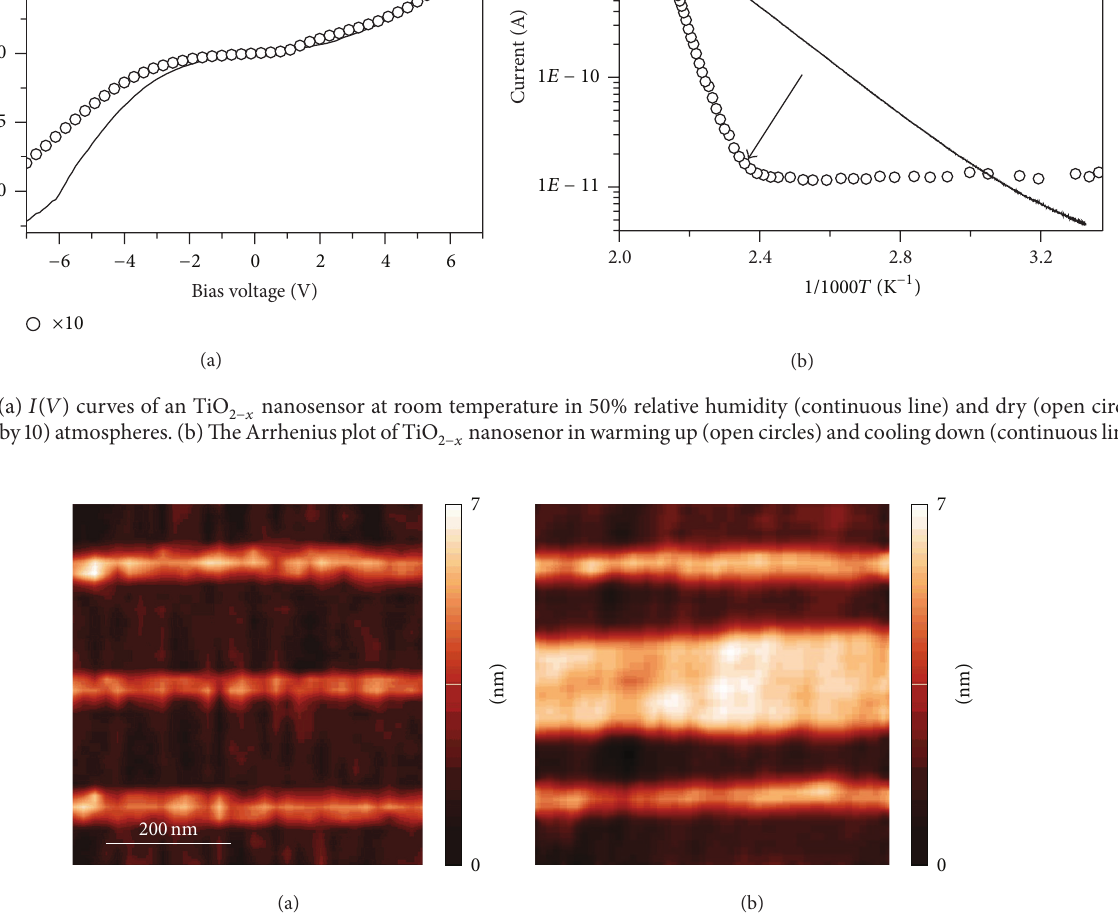
Figure 9: (Color online) AFM topographic images of a MoO 3 nanosensor before (a) and after (b) applying 1V bias voltage in dry atmosphere at room